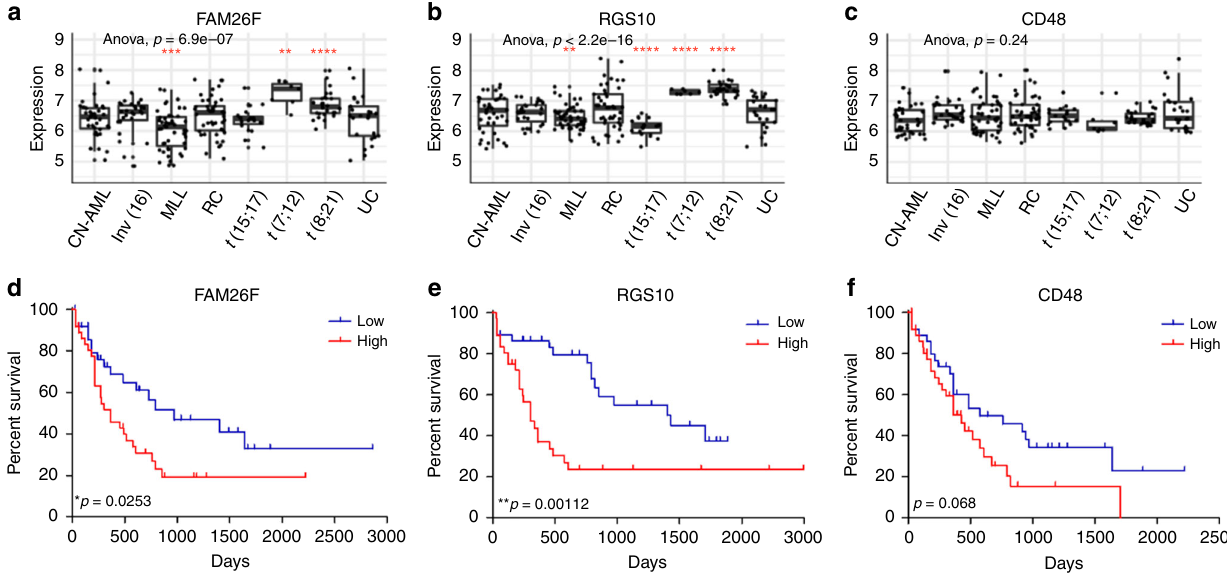
Fig. 6 Genes in paediatric signature associate with AML subtypes and prognosis. Expression of a FAM26F, b RGS10 and c CD48 in paediatric AML patients (GSE17855) categorised by AML subtypes — cytogenetically normal AML (CN-AML, n = 39), AML with inv 16 ( n = 27), MLL rearranged AML (MLL, n = 47), AML with remaining cytogenetics including t (6;9), monosomy 7, trisomy 8 and complex karyotype (RC, n = 45), AML with translocations t (15;17) ( n = 19), t (7;12) ( n = 7) and t (8;21) ( n = 28) and patients with unknown cytogenetics (UC, n = 25). Signi fi cance determined by one-way ANOVA and one sample t -test using the ggpubr package (https://CRAN.R-project.org/package = ggpubr) * p < 0.05, ** p < 0.01, *** p < 0.001, **** p < 0.0001. d – f Kaplan – Meier survival analysis of overall survival of AML patients ( n = 150) in the TCGA L-AML dataset with high (top quartile, n = 37) and low